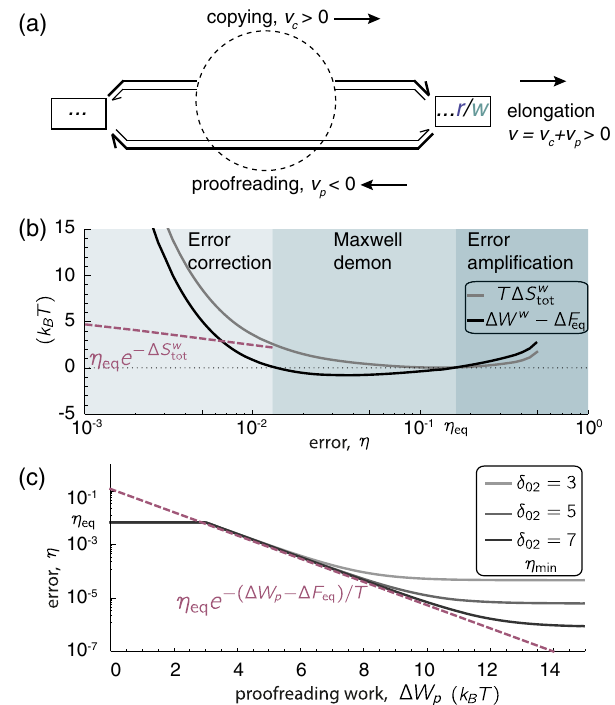
FIG. 5. Regimes and bounds of kinetic proofreading.